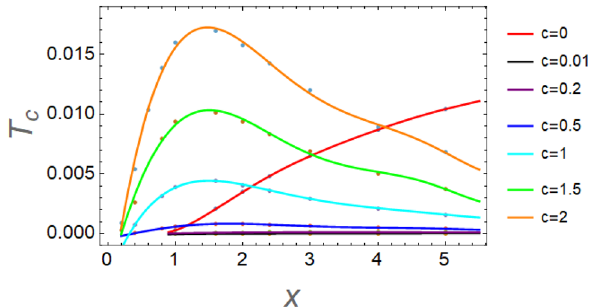
Fig. 2 Role of c . We plot the superconducting phase with different c = 0 , 0 . 01 , 0 . 2 , 0 . 5 , 1 , 1 . 5 , 2 a = b = 0. No dome without c .